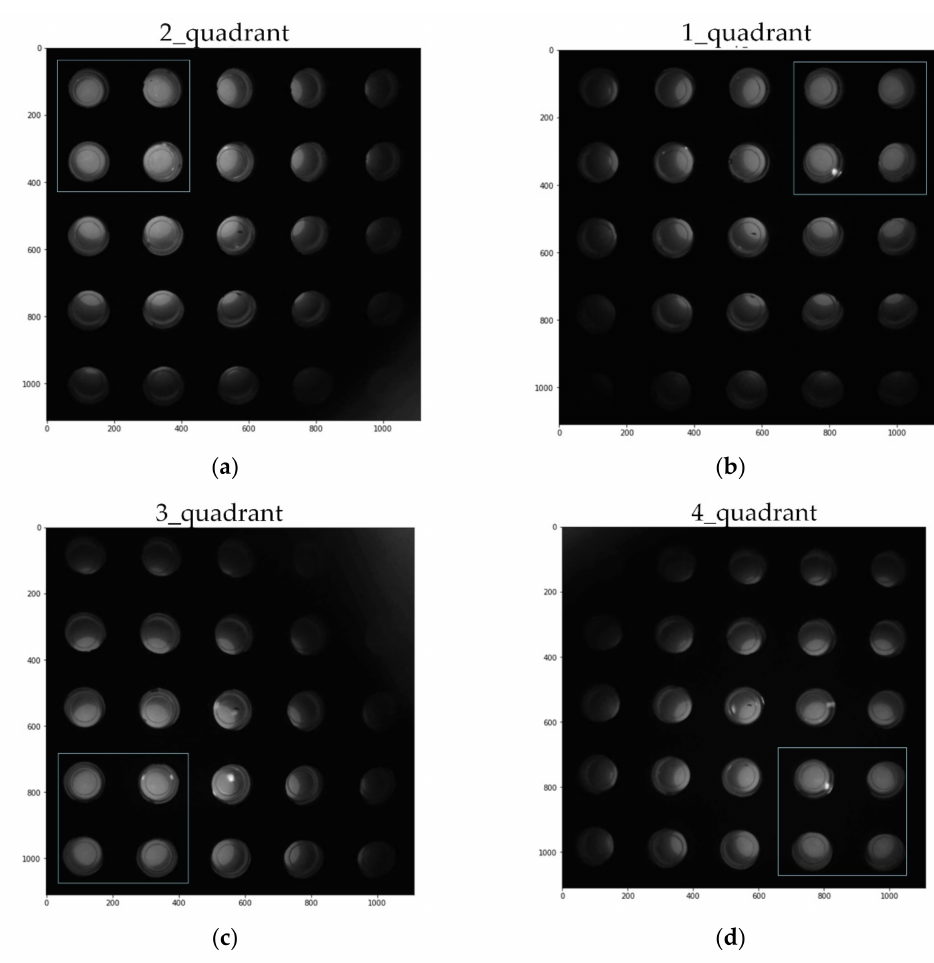
Figure 10. Image cropped to the same size in the center (FAM): ( a ) 2 quadrant; ( b ) 1 quadrant; ( c ) 3 quadrant; ( d ) 4 quadrant.